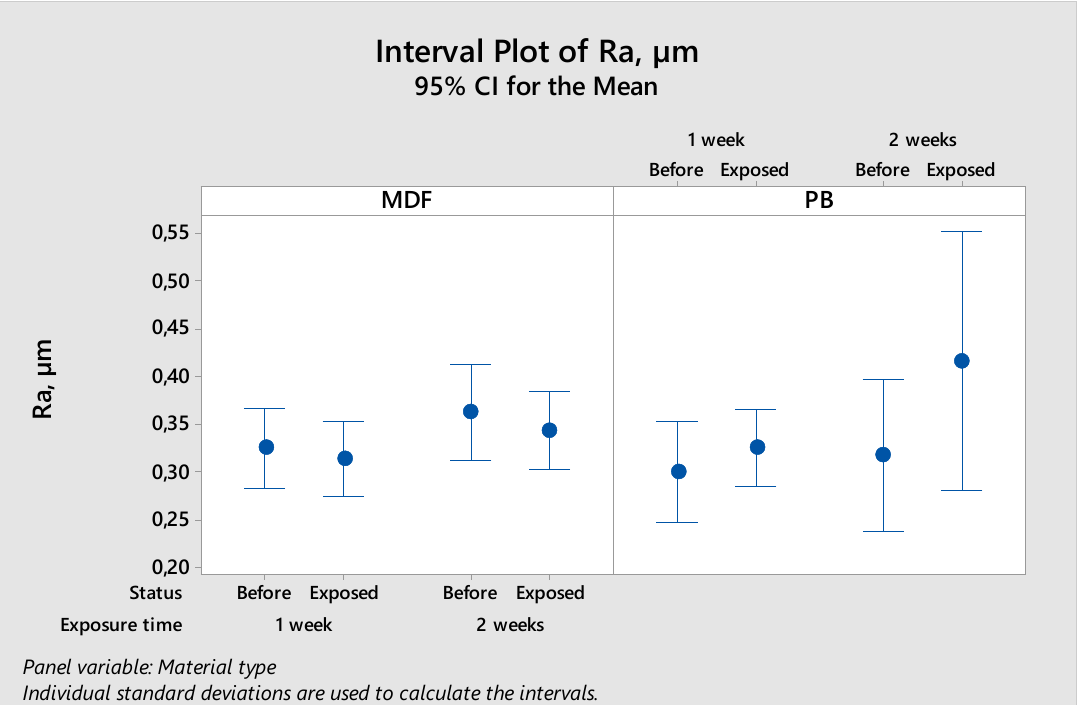
Figure 4. Variation of the mean peak-to-valley height parameter ( Rz ) of the raw MDF and PB samples, before and after exposure to humidity conditions.